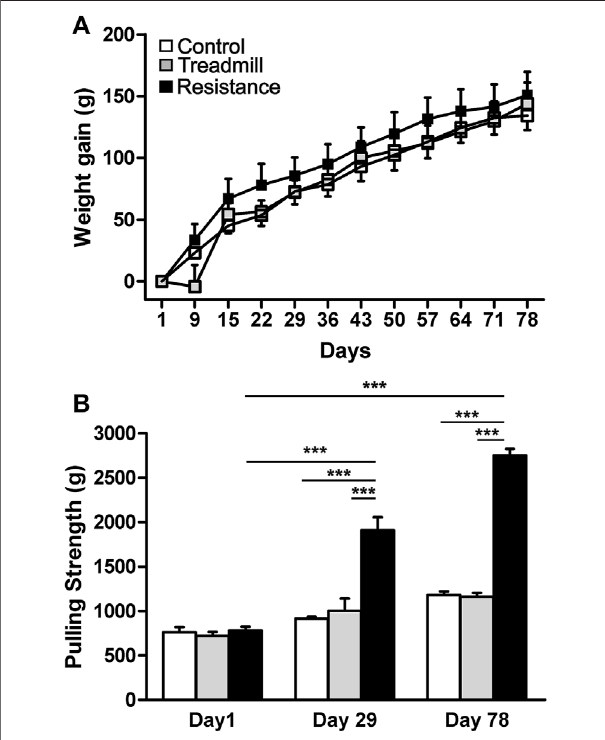
FIGURE 3 | Effect of exercise on body weight gain and pulling strength. Upper panel (A) shows the weight gain in control rats (open) and rats subjected to either treadmill exercise (gray) or resistance exercise (black). There was no signi fi cant difference in the body weight gain between control rat group and those of resistance exercised and treadmill-exercised rats ( p > 0.05). The graph bar in the lower panel (B) illustrates the pulling strengths in control rats and rats subjected to either resistance exercise or treadmill exercise. Resistance exercise group showed greater strength when compared to either the control rats or the rats running on the treadmill (*** p < 0.001). There was signi fi cant increase in strength of resistance exercised rats from day1 to day 29 (*** p < 0.001) and day 78 (*** p <